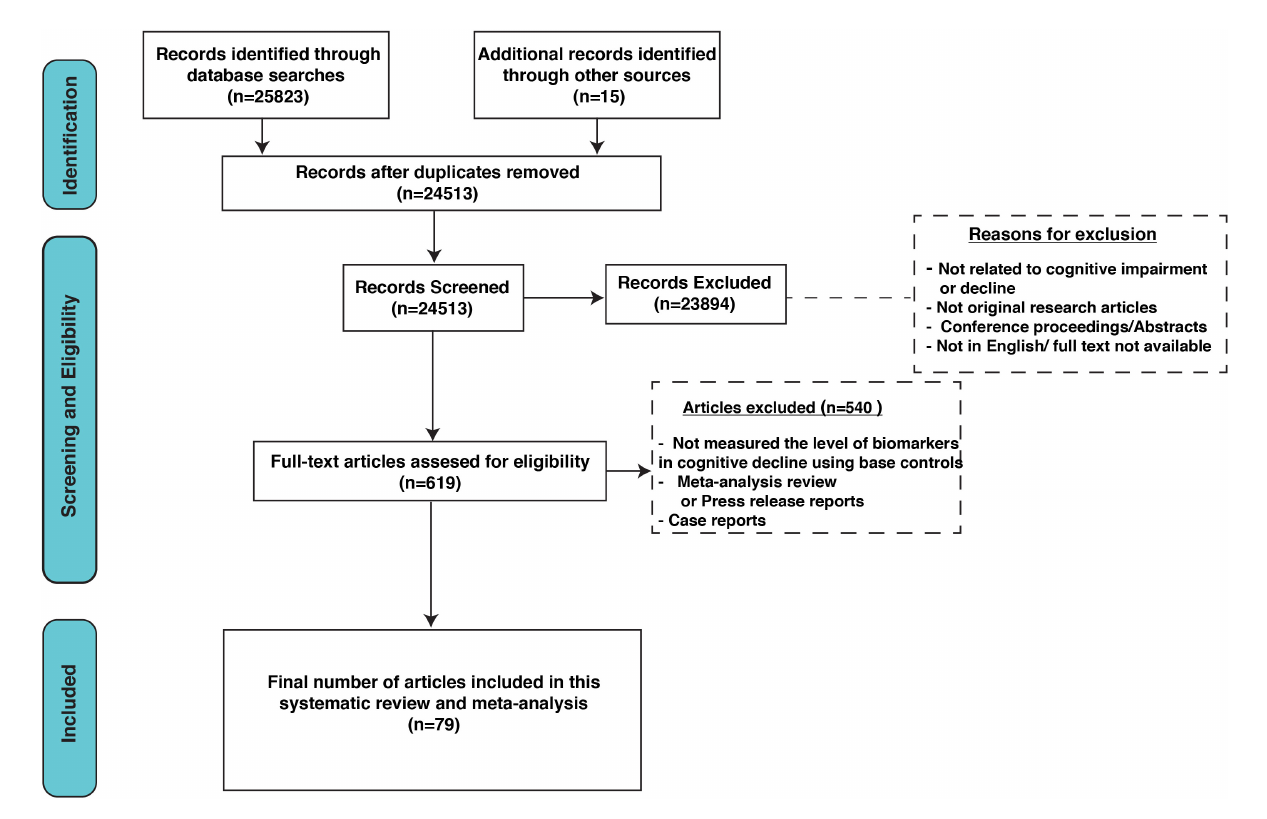
FIGURE1 Preferred Reporting Items for Systematic Reviews and Meta-Analyses (PRISMA) flow